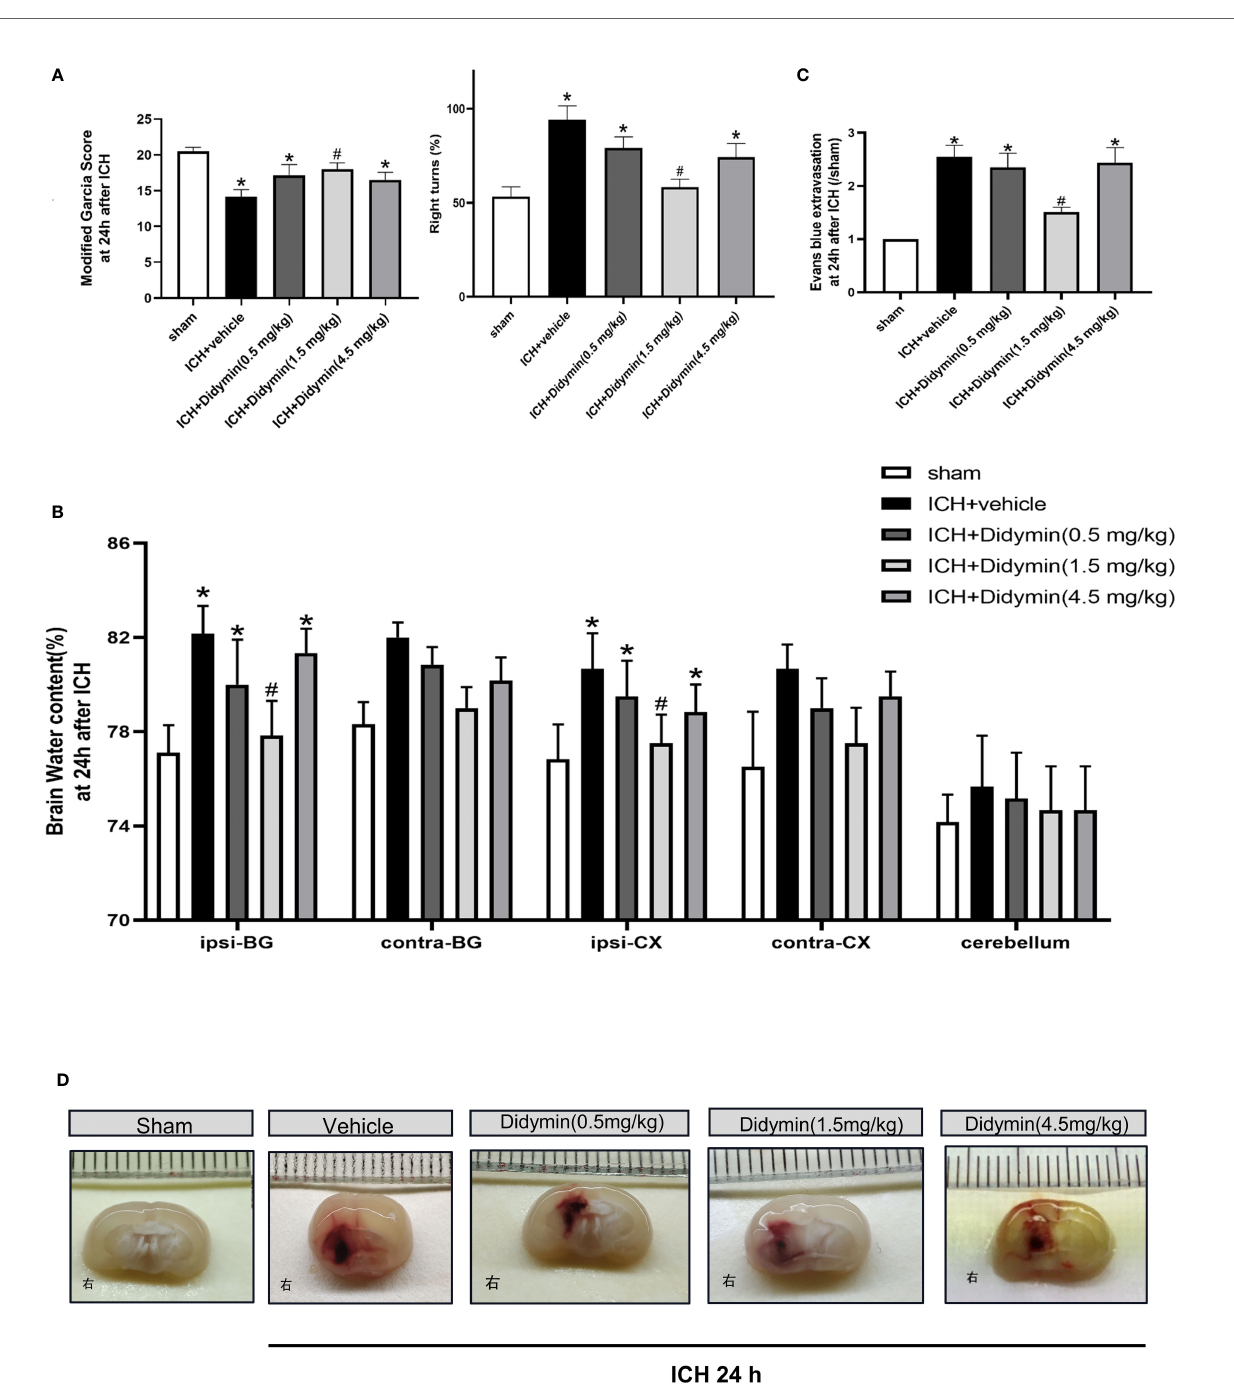
FIGURE 2 | Neuroprotective effects of Didymin on brain injury after ICH. (A – D) Neurological de fi cits, brain water content, EB extravasation, and hematoma size were tested at 24 h after ICH. Ipsilateral basal ganglia (ipsi-BG), contralateral basal ganglia (contra-BG), ipsilateral cortex (ipsi-CX), contralateral cortex (contra-CX), and cerebellum. n = 6 per group. * p < 0.05 vs. sham; # p < 0.05 vs.